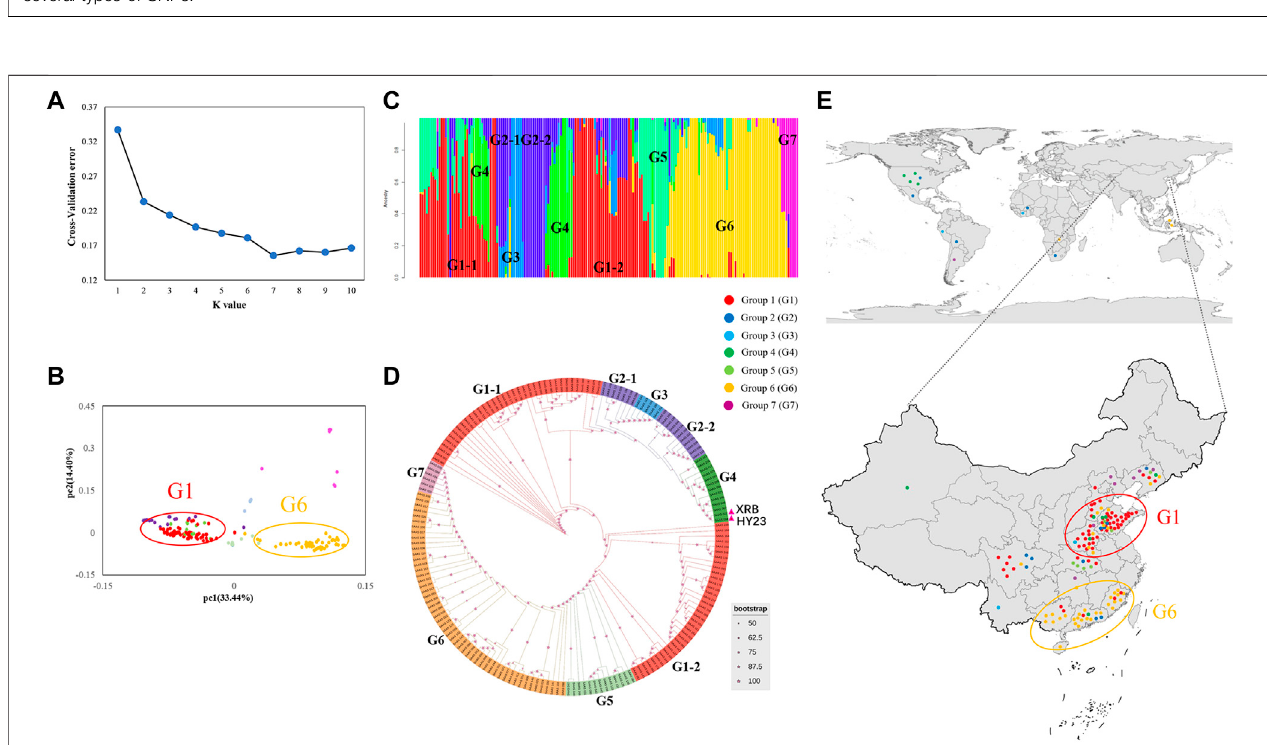
FIGURE3| Populationstructureandgeneticdiversityofthe178peanutvarieties. (A) Cross-validationvalueofeachKrangingfrom1to10. (B) ThePCAanalysisof the total accessions. Each dot represents one variety. (C) Population structure. Each variety is represented with a single vertical line, and the color represents ancestry. (D) Phylogenetic trees constructed by the maximum likelihood method. (E) Geographical distribution of total varieties.